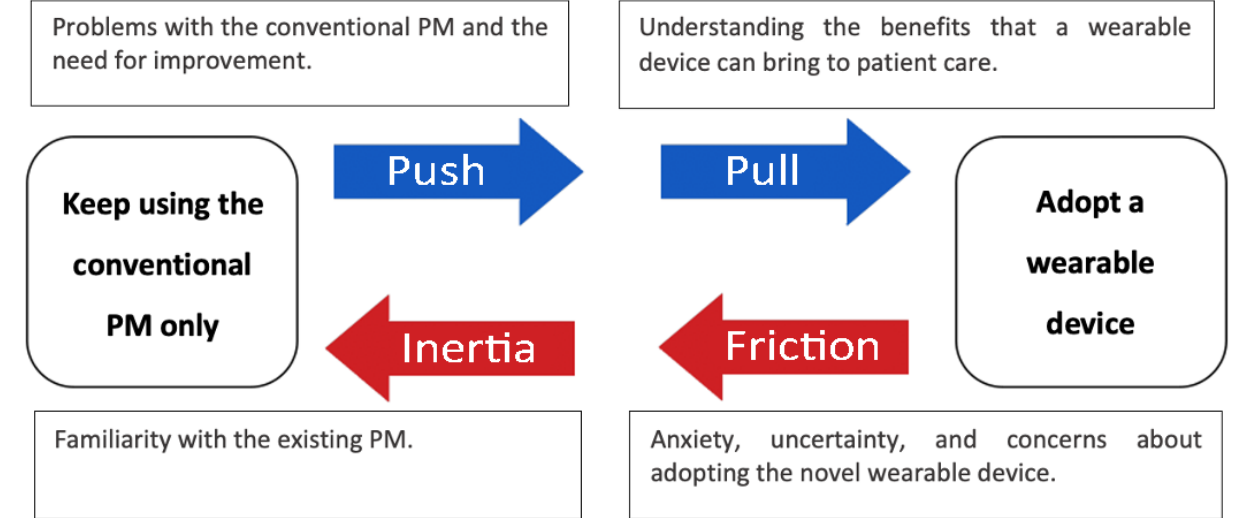
Figure 11. Balance of forces acting on the decision making of the clinicians when deciding if they should augment the patient monitor (PM) with a wearable display for critical care or continue only using the PM. Diagram adapted from the concept presented in “The Science of How Customers Buy Anything,” by Maurya [24].